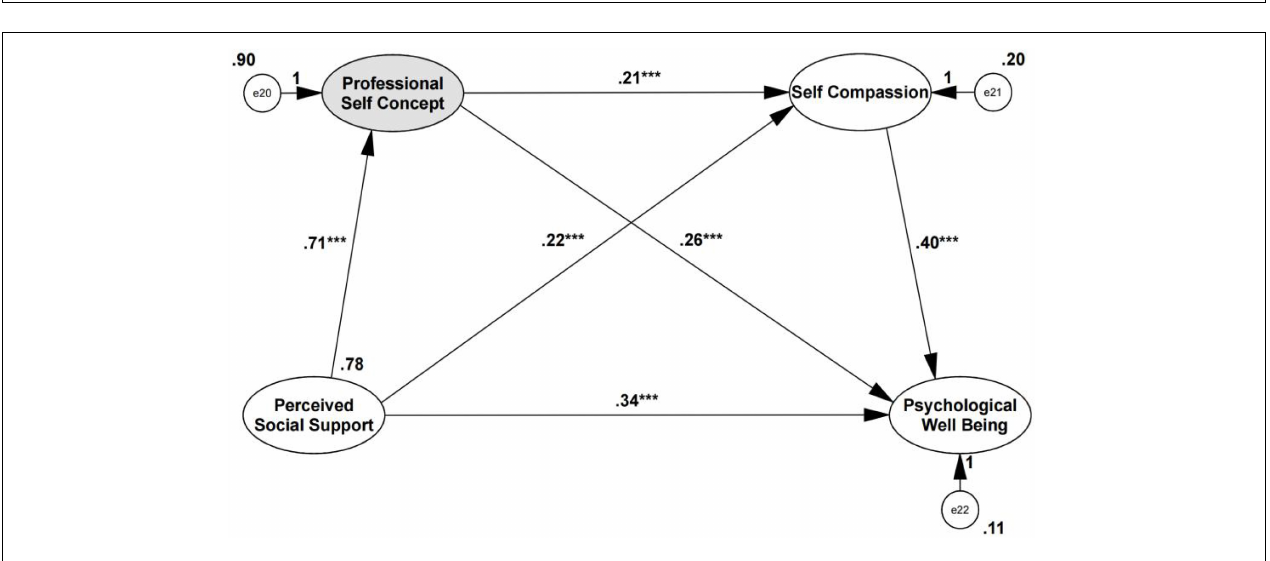
FIGURE 2 | Model of Directionality 1: self-compassion to professional self-concept. After adding the mediators, there is a significant indirect effect of perceived social support on PWB. The coefficients shown above are unstandardized. *Significant at the 0.05 level (two-tailed). **Significant at the 0.01 level (two-tailed). ***Significant at the 0.001 level (two-tailed). The total effects (Ind1 + Ind2 + Ind3 + direct effect) = 0.671. The total indirect effects (Ind1 + Ind2 + Ind3) = 0.334.